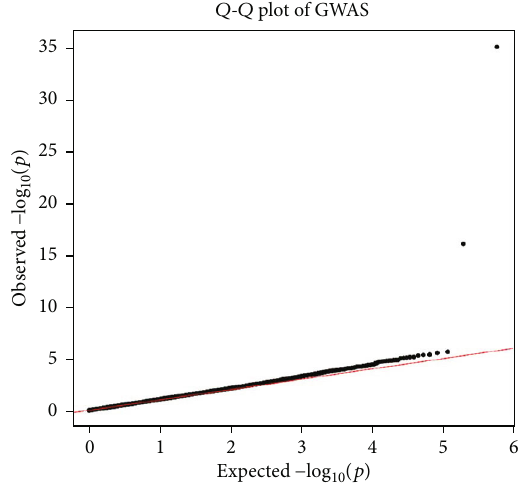
Figure 3: Q – Q plot of genome-wide association study (GWAS) between AD and HC groups. Genomic in fl ation factor is